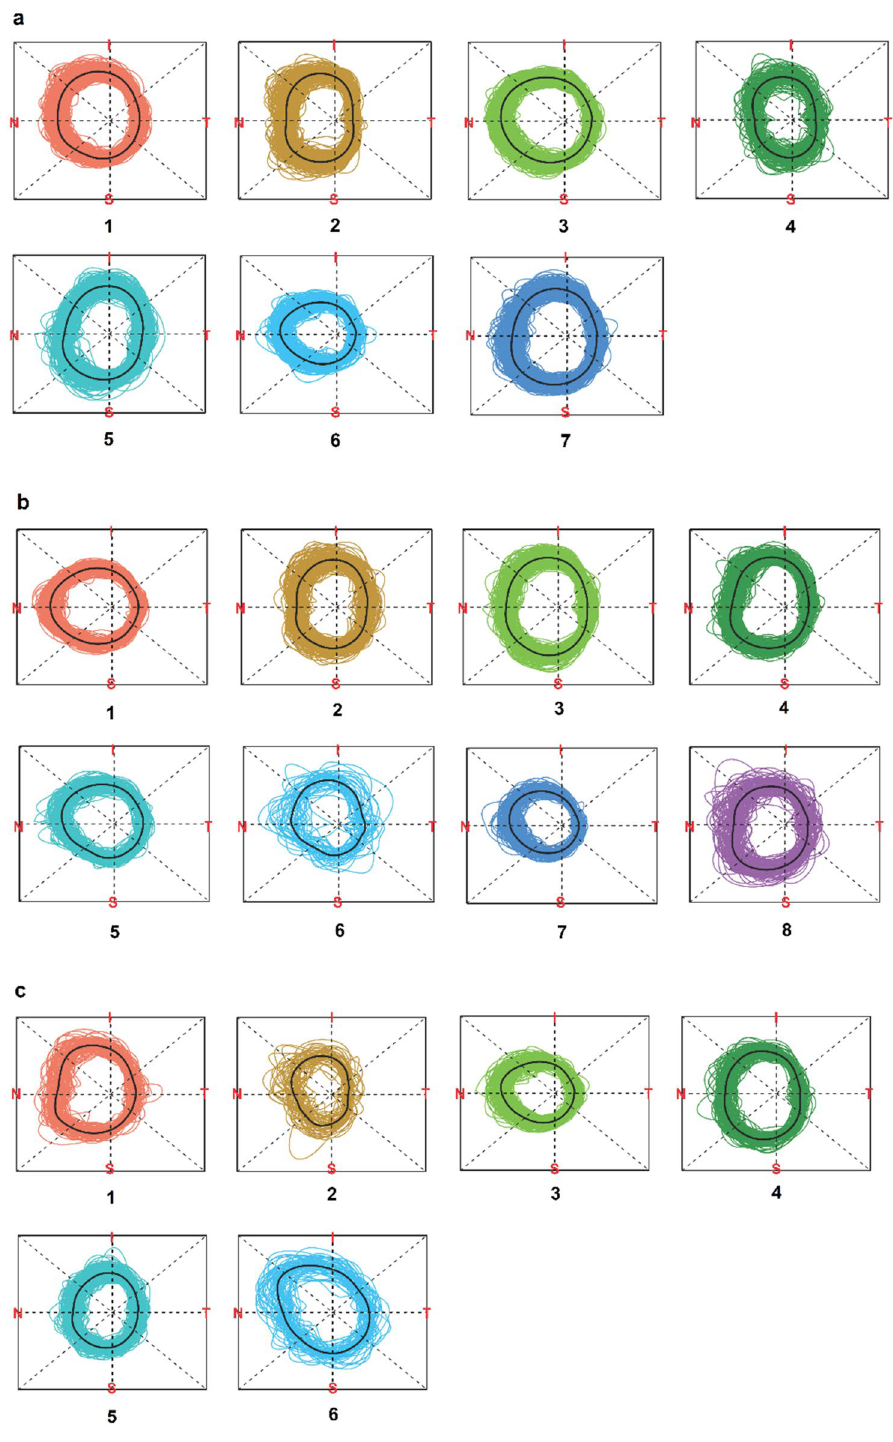
Figure 3. The clusters of the OCT NRR functional data are shown. For each of the age groups ( a ) 1, ( b ) 2, and ( c ) 3, the normalized NRR curves that belong to the same cluster are shown together using a common color. In age groups 1, 2, and 3, CIFU identified 7, 8, and 6 clusters respectively. For each cluster, its mean NRR curve is shown in black. The direction of the NRR curves is given by TSNIT